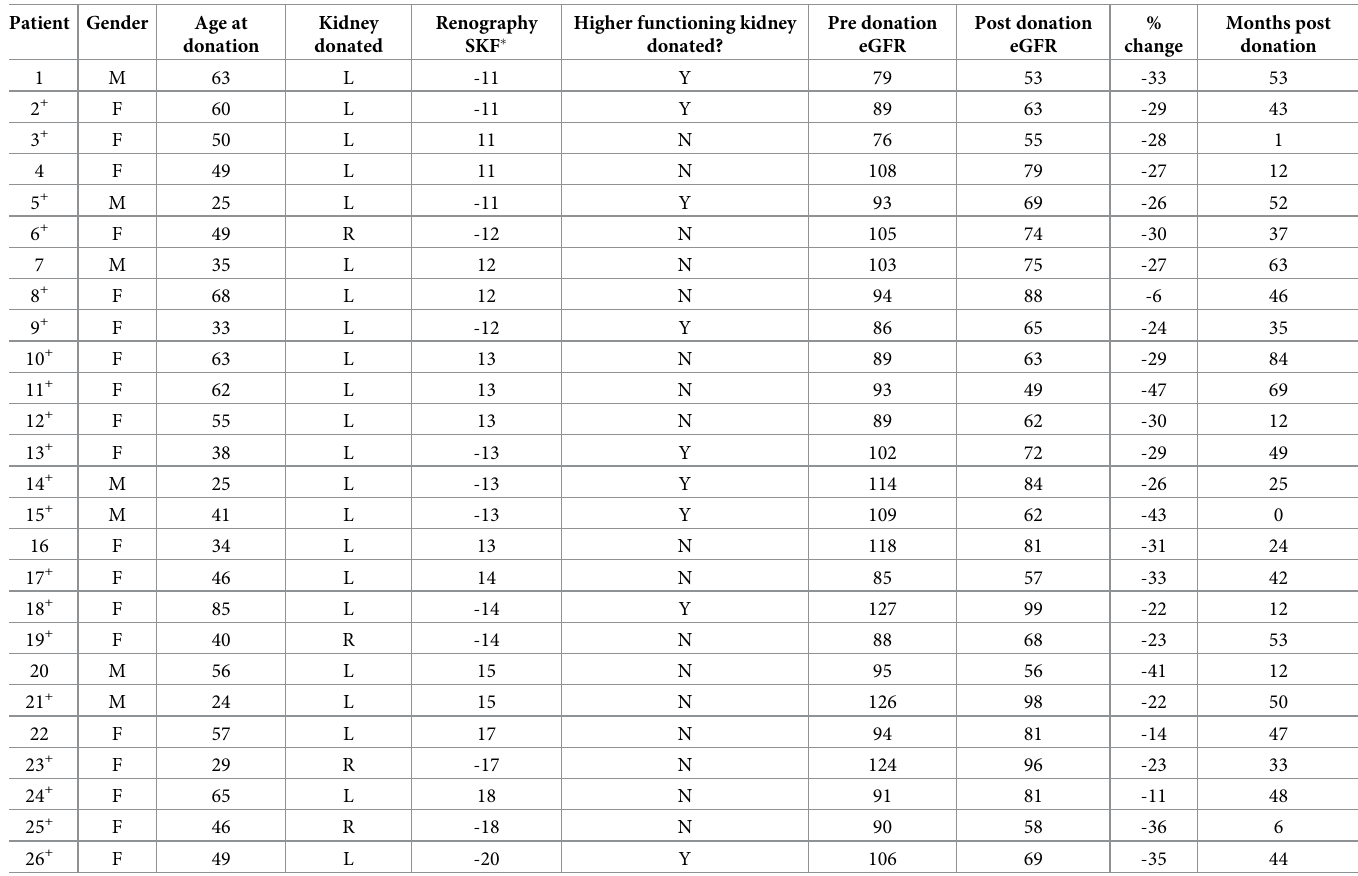
Table 3. Characteristics for donors with > 10% SKF difference on renography, n = 26.